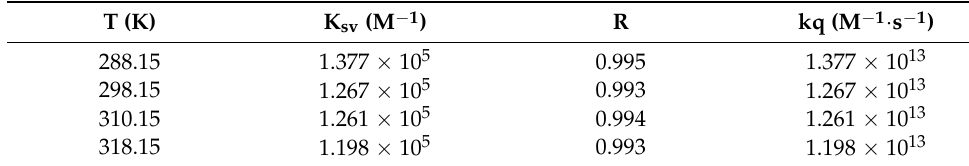
Table 1. Stern–Volmer quenching (K SV ) constants, regression coefficients (R), and quenching rate (kq) constants at different temperatures and pH 7.4 for the interaction of PAZ with